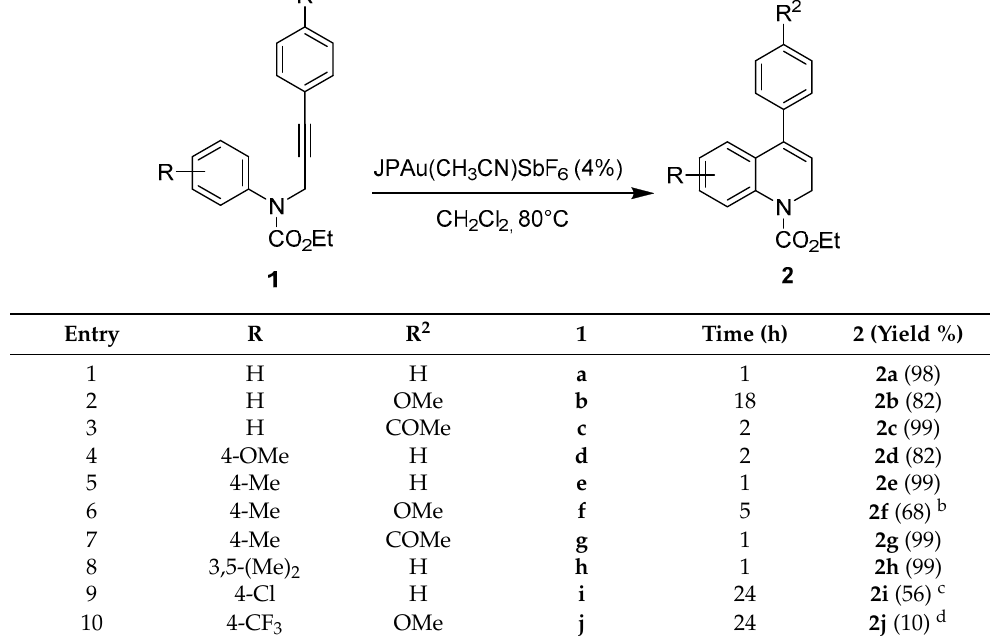
Molecules 2021 , 26 , x FOR PEER REVIEW